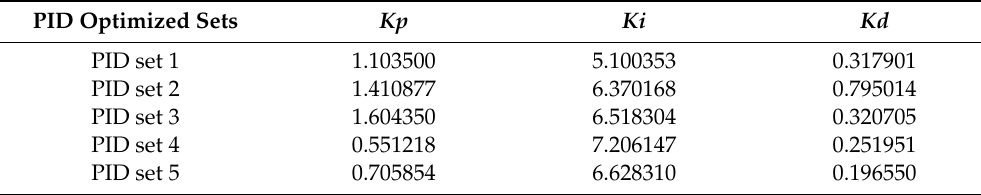
Table 5. Optimized sets of